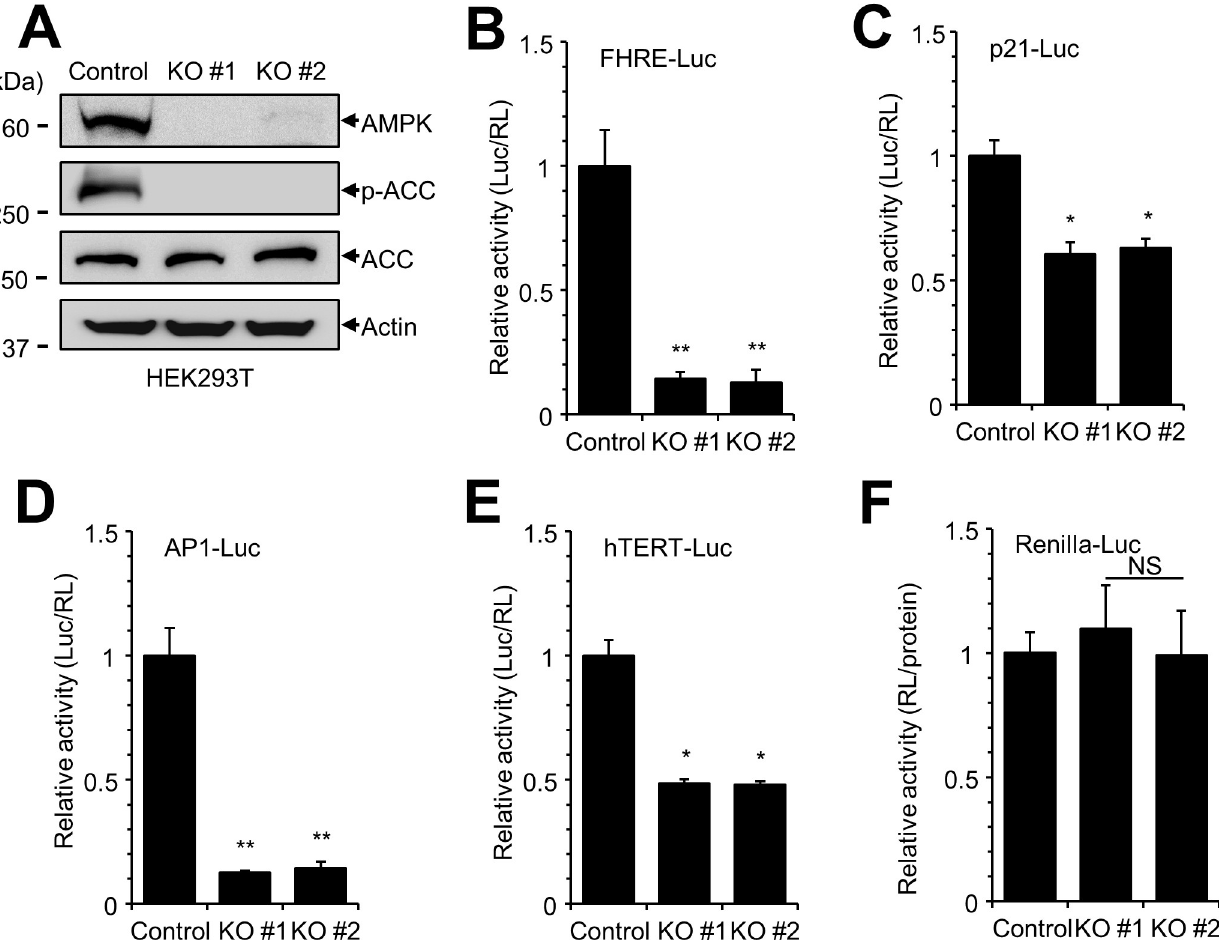
Fig 1. Signaling pathway screening in AMPK α 1 knockout (KO) HEK293T cells. ( A ) The expression of AMPK α 1 protein was examined in AMPK α 1 knockout (KO) HEK293T cells by western blotting with the indicated antibodies. ( B-E ) HEK293 cells were transfected with various luciferase constructs (FHRE-Luc, p21-Luc, AP1-Luc, and hTERT-Luc) and internal control plasmids (pCMV-RL). At 24 h after transfection, luciferase reporter activity was measured and normalized to activity of Renilla luciferase. The experiment was performed in at least triplicate, and the graph shows average and standard error. Control vs. AMPK α 1 KO, � P < 0.005, �� P < 0.0001, NS, not significant. ( F ) Plasmid encoding Renilla-Luc under control of the CMV promoter was used an as internal control to monitor the transfection efficiency. Renilla luciferase activity was normalized to total protein concentration in each sample.